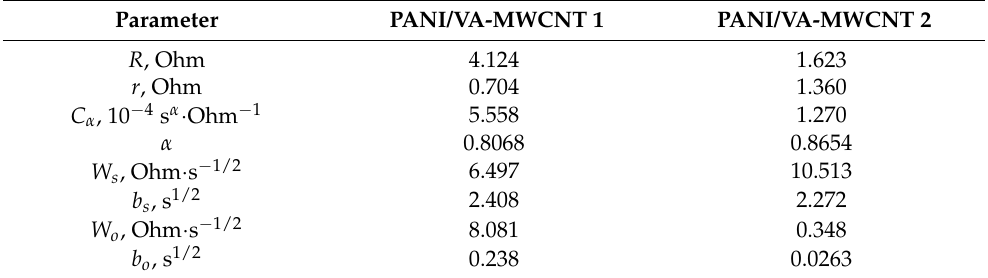
Table 1. Parameters of the equivalent circuit model.